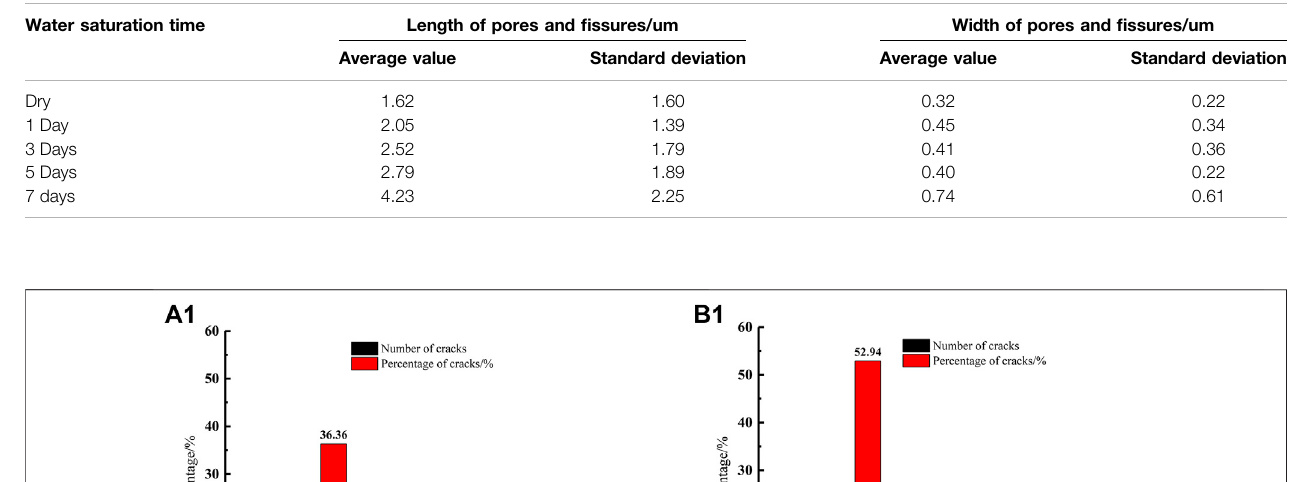
TABLE 3 | Characteristics of limestone pores and fi ssures at different water saturation